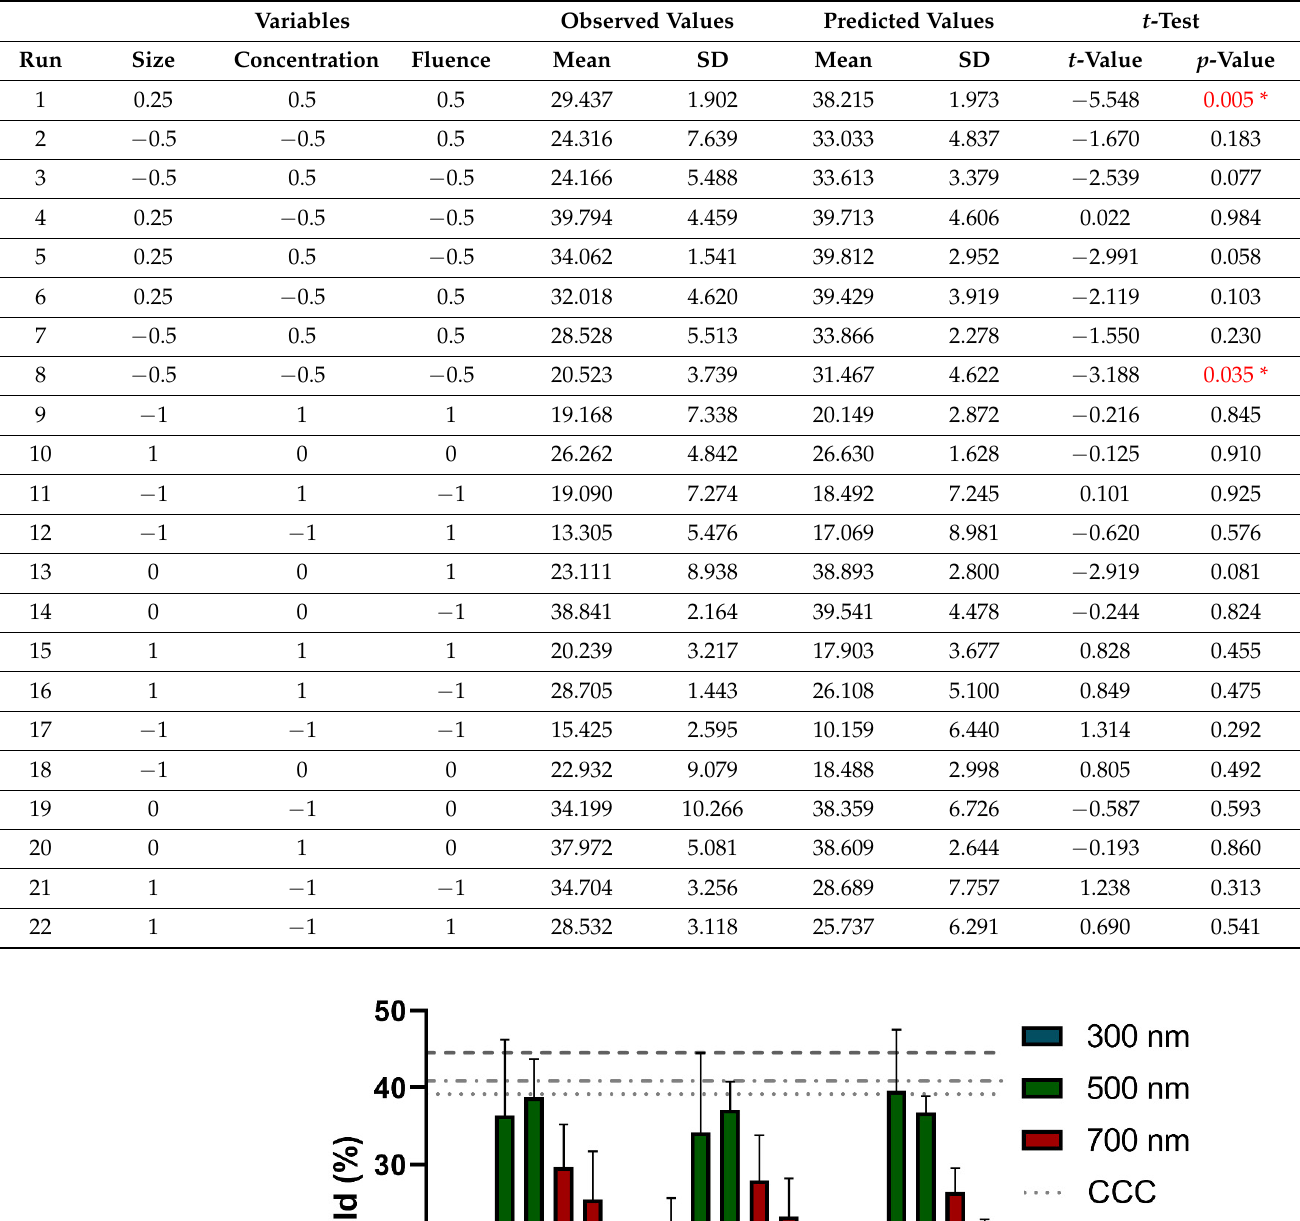
Table 4. Summary of the unpaired Welch’s t -test between the averaged predicted values and averaged observed values for the BBD-based models, with standard deviations (SD) also reported. Values indicated in red and with * are significant at p < 0.05.